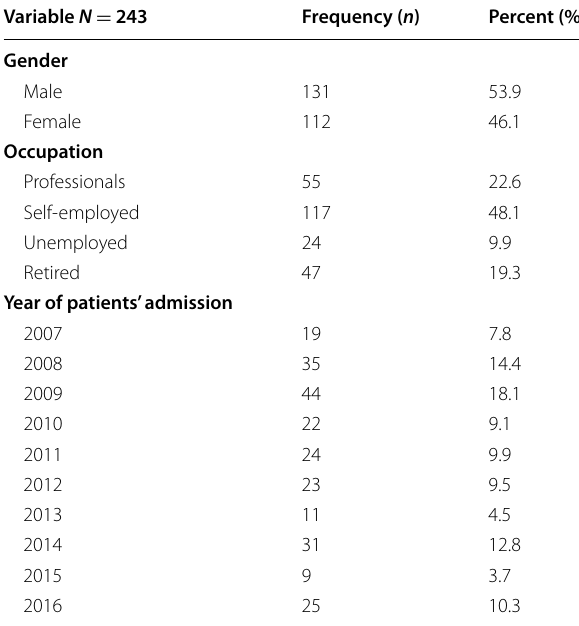
Table 1 Socio-demographic characteristics of stroke patients ( N